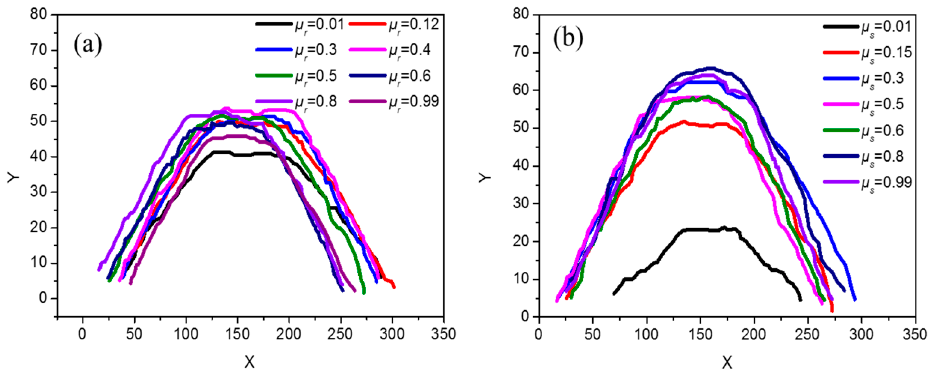
Figure 4. Extracted contours of the pellet pile for different ( a ) rolling and ( b ) static friction coefficients.